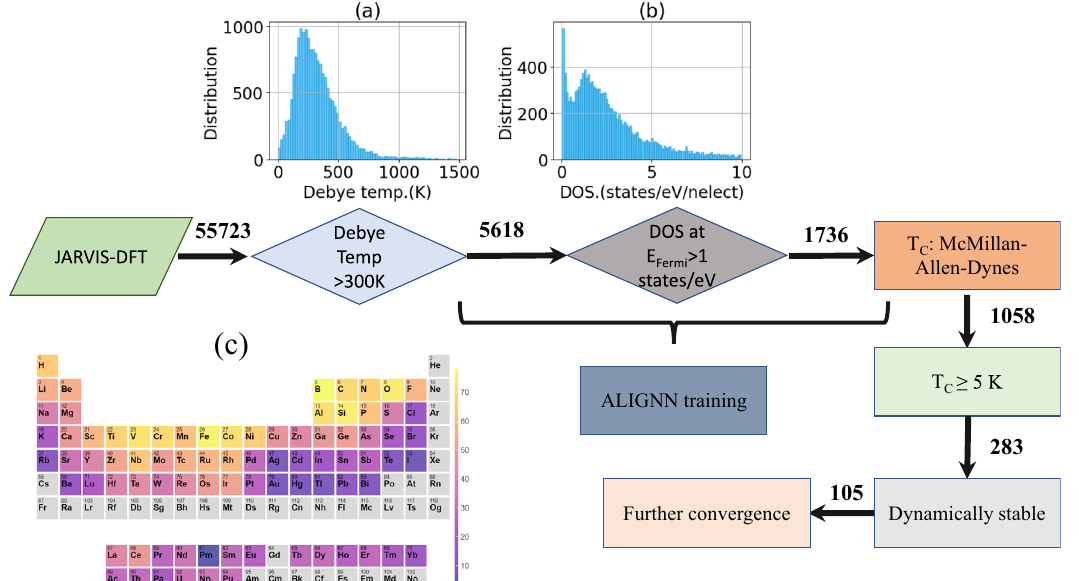
Fig. 1 Schematic showing the steps involved in identifying high- T C superconductors. a statistical distribution of Debye temperature (K) and b statistical distribution of electronic density of states (states/eV/total number of electrons) at Fermi level from the JARVIS-DFT database, c probability that compounds containing a given element have θ D > 300 K. The fl ow chart shows the application of BCS-inspired screening, density functional theory calculations, and deep-learning training.